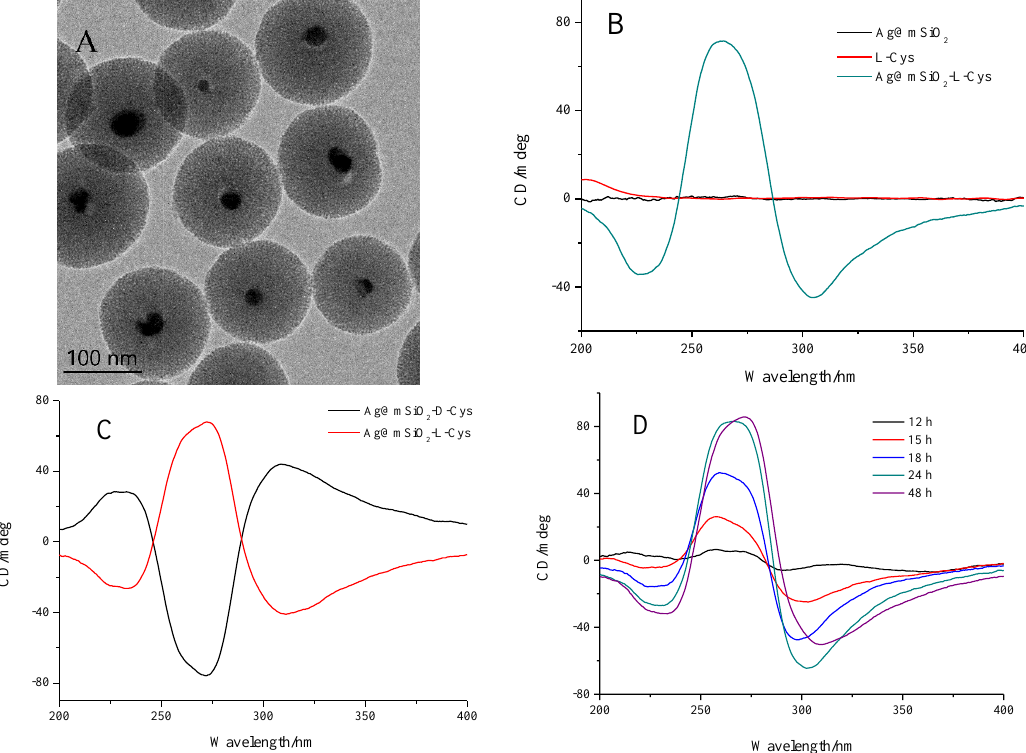
Figure 5. ( A ) Transmission electron microscopy (TEM) image of the mesoporous silica coated Ag nanoparticles (NPs) (Ag@mSiO 2 ) after etching; ( B ) The circular dichroism (CD) spectra of Ag@mSiO 2 , L-Cys solution and Ag@mSiO 2 -L-Cys; ( C ) CD spectra of Ag@mSiO 2 -L-Cys and Ag@mSiO 2 -D-Cys; ( D ) The evolutions of CD spectra of Ag@mSiO 2 -L-Cys with the reaction time.